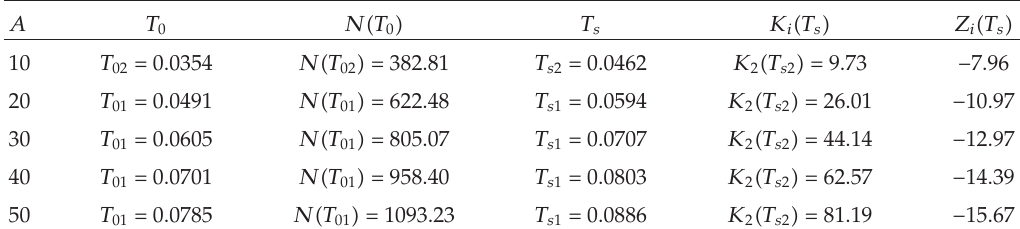
Table 1: Optimal solution for di ff erent ordering